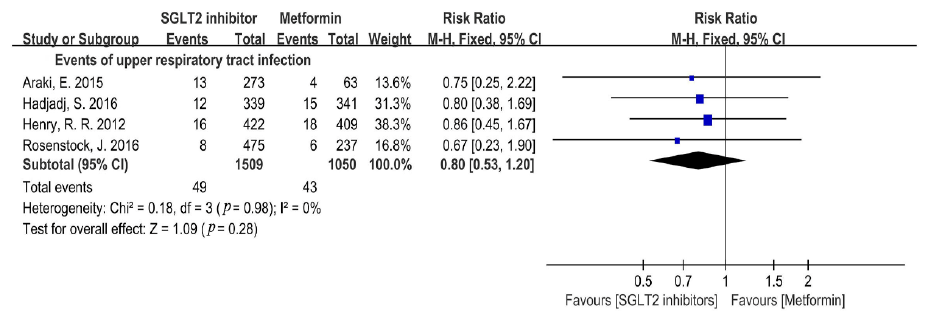
Figure 11. Risk of upper respiratory tract infections in SGLT2i group compared with that of metformin [20,22,24,29].